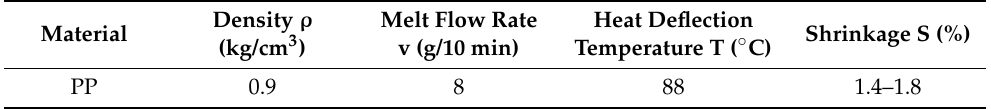
Table 2. Material properties of polypropylene